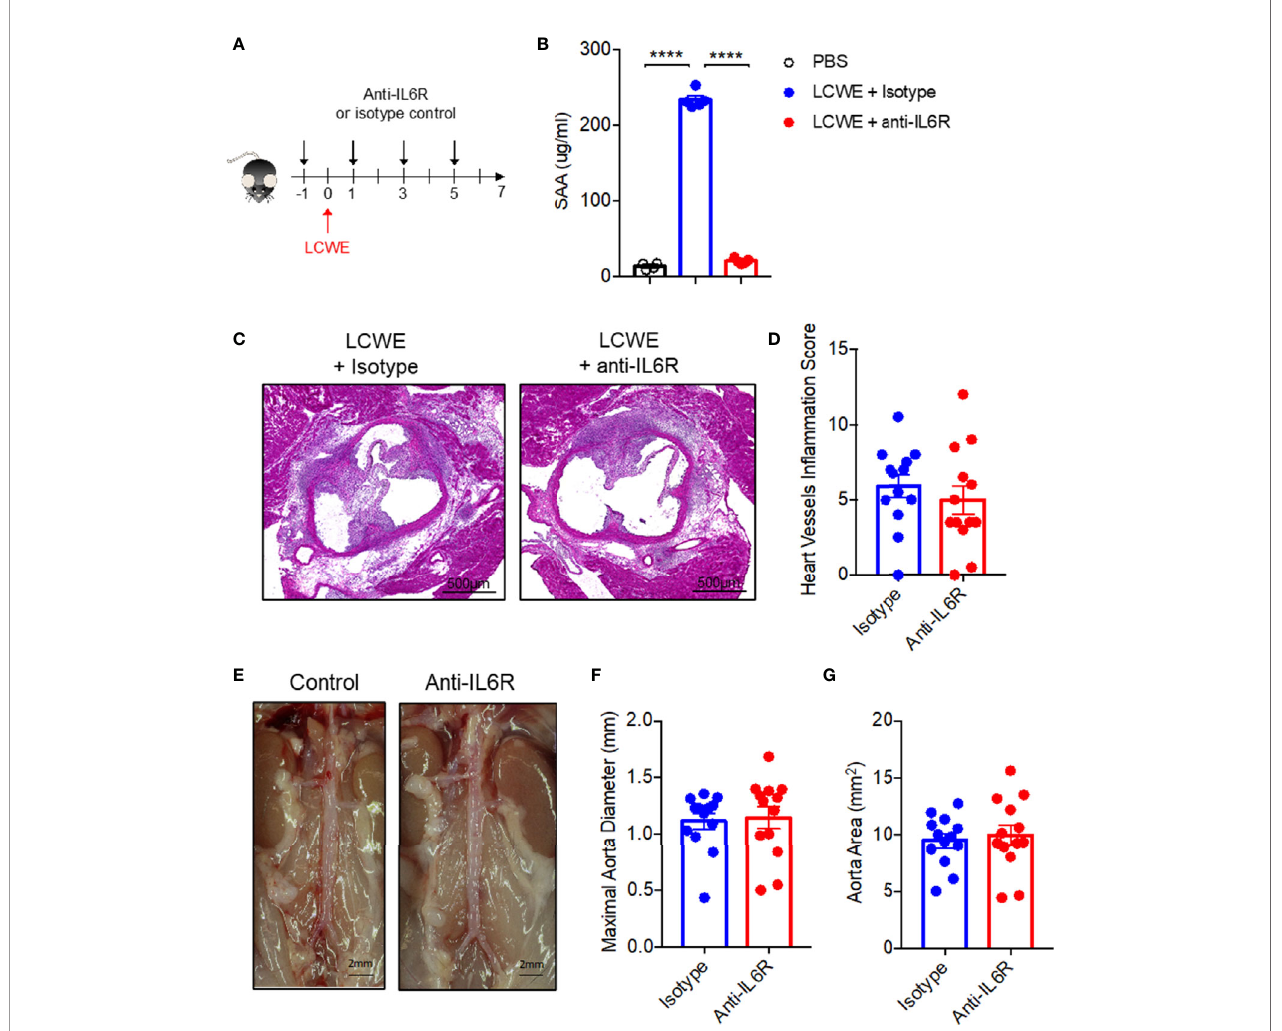
FIGURE 5 | Blocking IL-6R signaling fails to attenuate LCWE-induced KD vasculitis. (A) Schematic of the experimental design. (B) SAA concentration in serum from PBS or LCWE mice treated with isotype control or anti-IL6R antibody. (C, D) Representative H&E stained heart sections (C) and heart vessel in fl ammation scores (D) of LCWE-injected WT mice treated with either isotype control or anti-IL6R antibody at 1-week post-LCWE injection. Scale bars, 500µm. (E) Pictures of the abdominal aorta area of LCWE-injected WT mice treated with either isotype control or anti-IL6R antibody at 1-week post-LCWE injection. (F, G) Maximal abdominal aorta diameter (F) and abdominal aorta area (G) of LCWE-injected WT mice treated with either isotype control or anti-IL6R antibody at 1-week post-LCWE injection. Results are from two independent experiments combined (n = 13 mice per group). Statistical analysis was performed by one-way ANOVA with Tukey ’ s multiple testing comparison (B) or Student ’ s t test (D, F, G) . ****p <